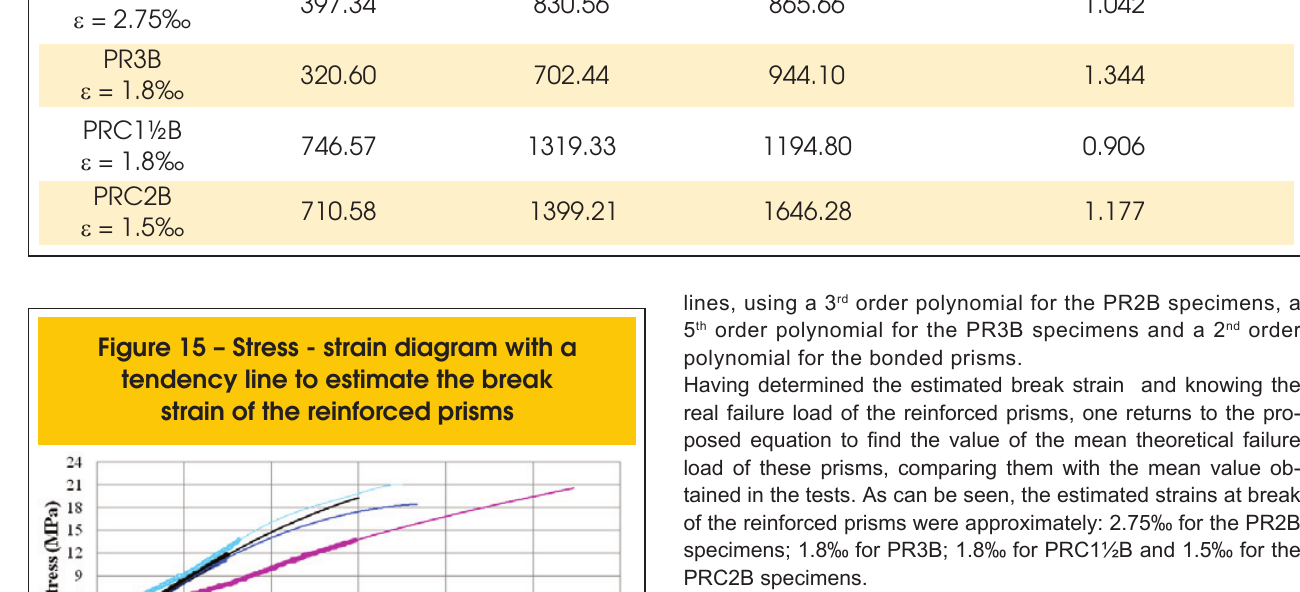
Table 6 – Comparison of mean theoretical and experimental loads for break strain (Model I) RUPTURE LOADS OF THE PRISMS (kN) Test